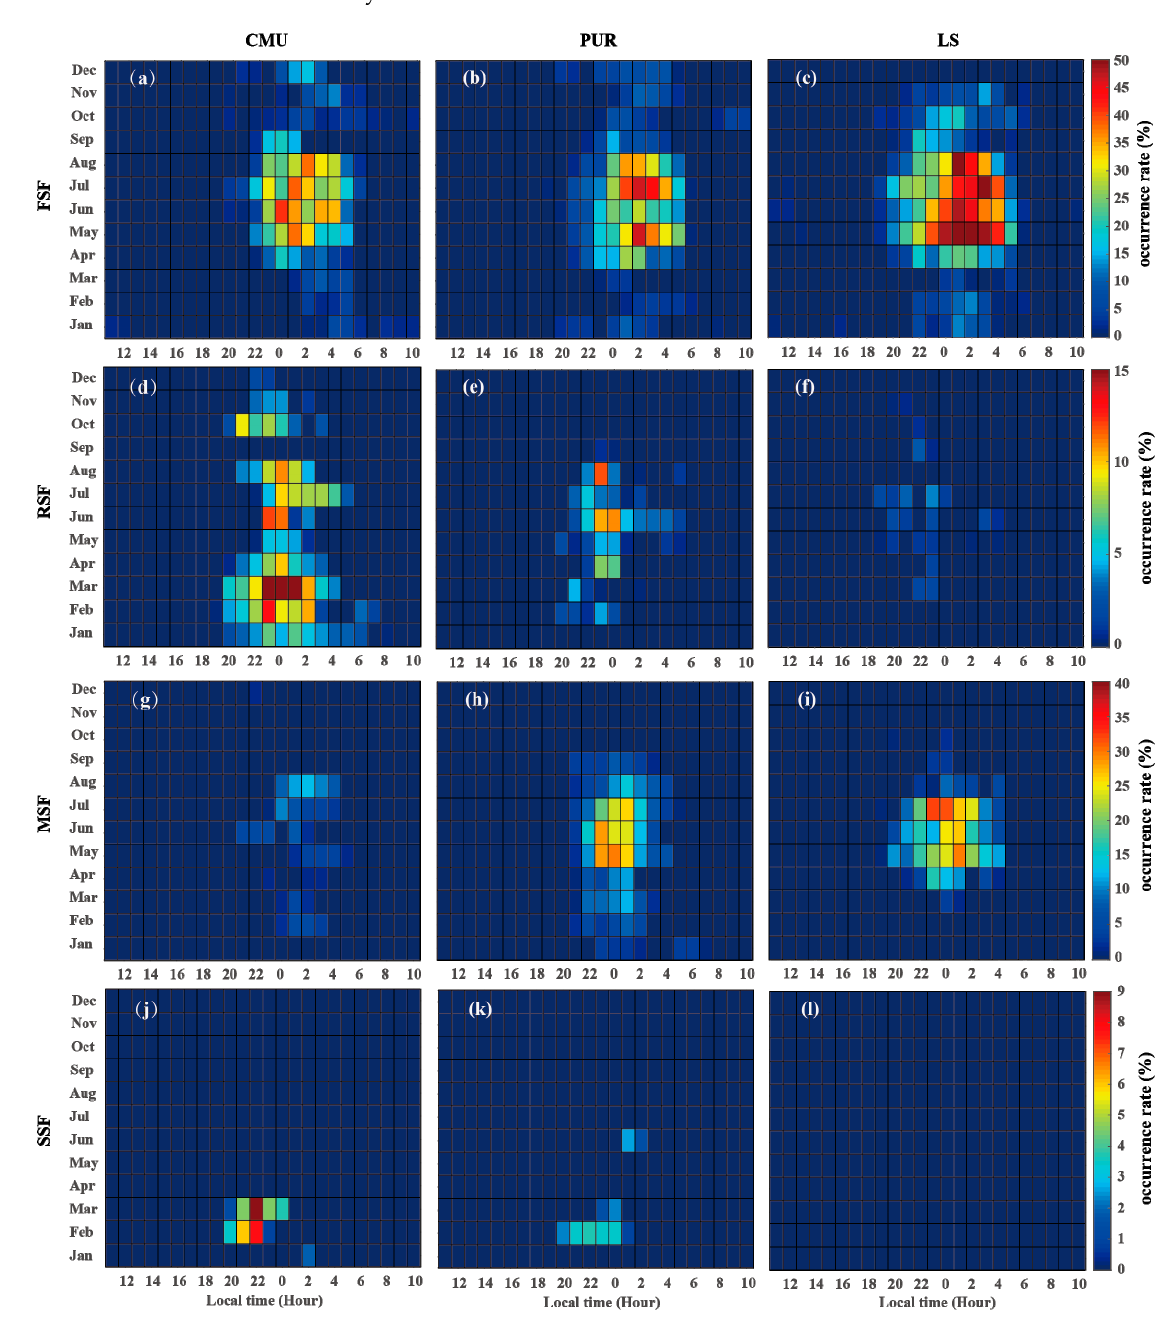
Figure 4. The occurrence rate variations of each type of SF with month and local time (LT = UT + 7). From top to bottom, the subfigures correspond to FSF, RSF, MSF and SSF, respectively. From left side to right side, the columns correspond to CMU, PUR and LS stations, respectively. The color bars indicate the occurrence rates of each type of SF.